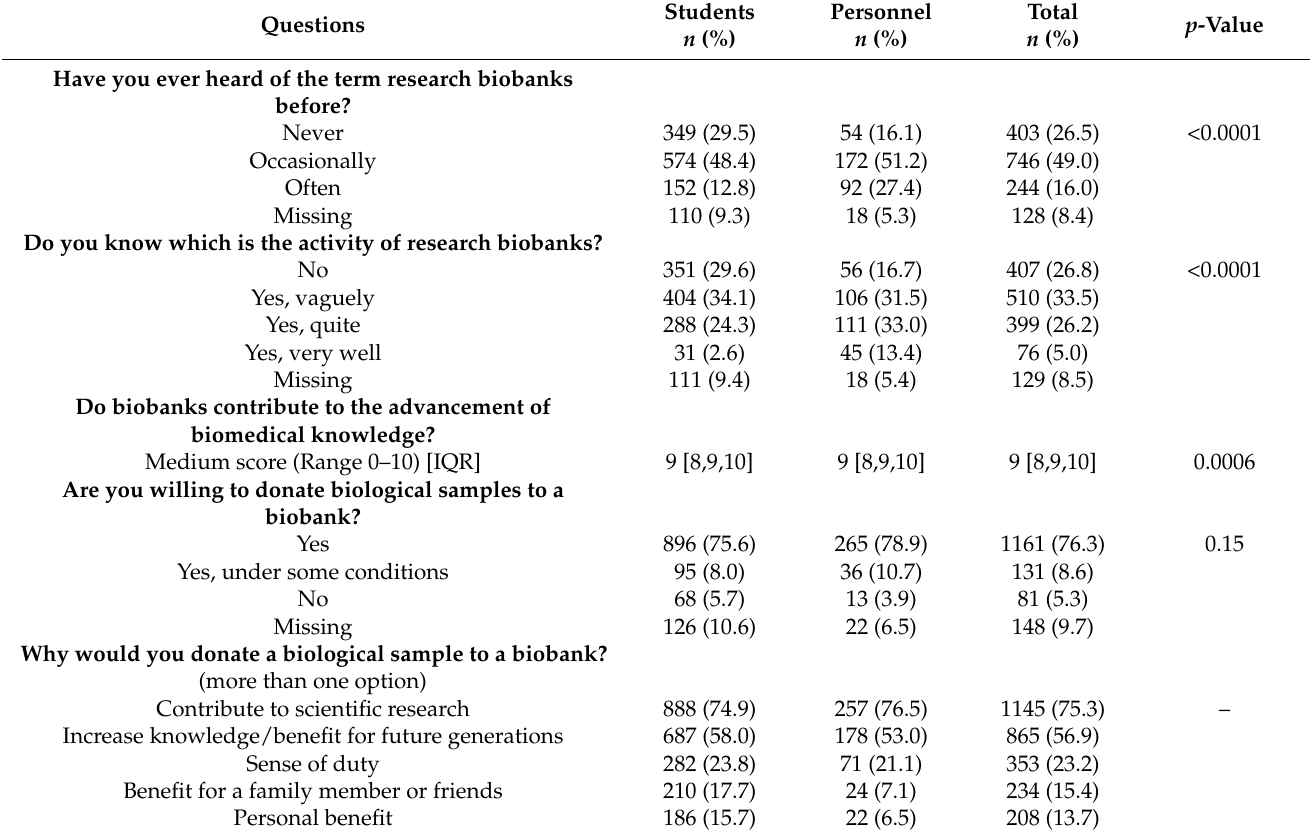
Table 3. Knowledge about biobanks and biobanking activities, concerns, and informed